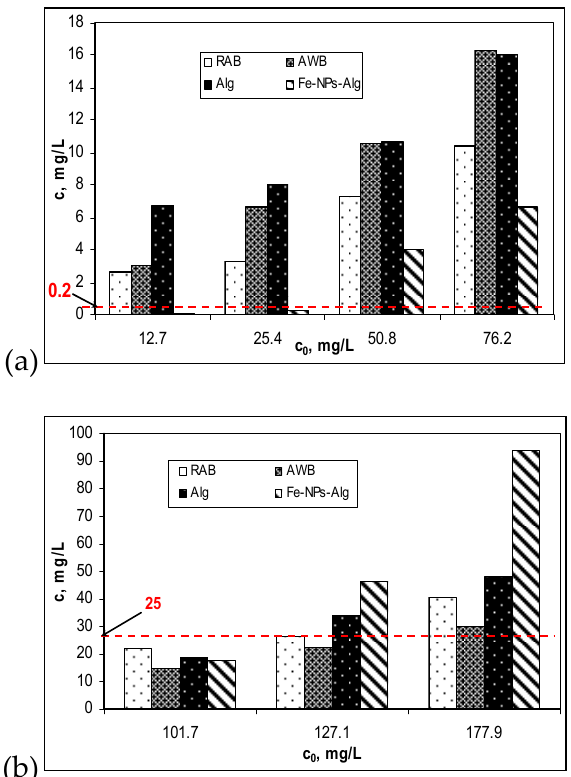
Figure 7. Variation of c (mg/L) vs. c 0 (mg/L), in low ( a ) and high ( b ) concentration range of Cu(II) ions.